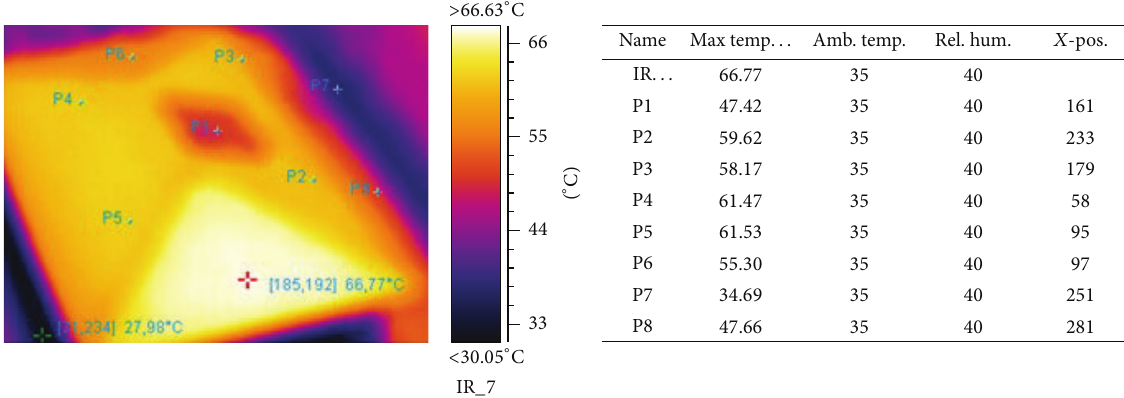
Figure 9: The thermal camera images and information of solar cells on top of